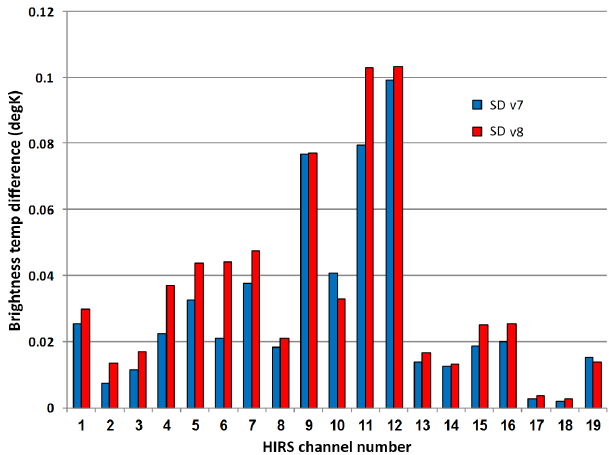
Figure 2. The mean standard deviation of the difference for Metop- A HIRS channels between the LBLRTM line-by-line model and RT- TOVv12 for the 83-profile set for all nadir views up to 63 ◦ using version 7 and 8 predictors with a surface emissivity of